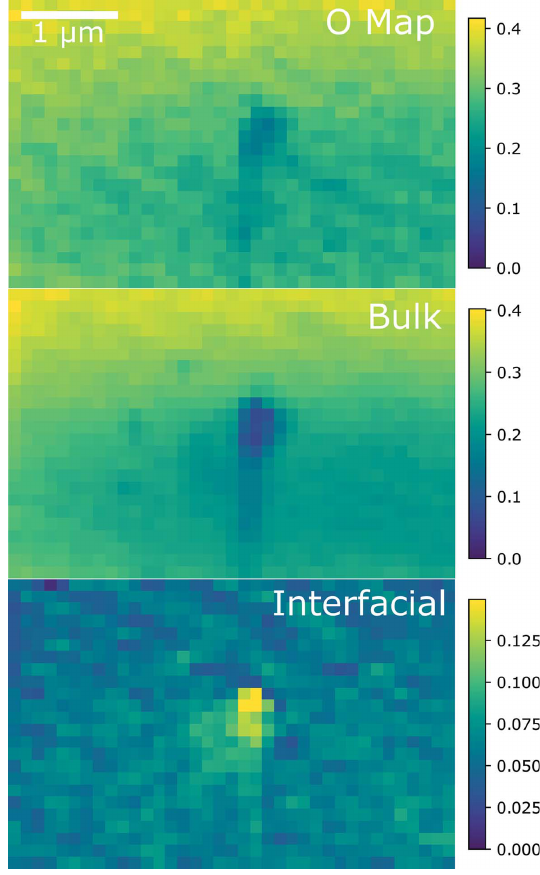
Figure 5 (Top) An oxygen map, and (middle) bulk and (bottom) interfacial species maps of FIB section 2A (sourced from the pellet’s center) near a defect in the sample. The color bars on the right-hand side indicate a quantitative measure of the oxygen content in each phase, with the scale corresponding to the oxygen edge step for each pixel. The STXM pixel size is 100 nm (cid:3) 100 nm.